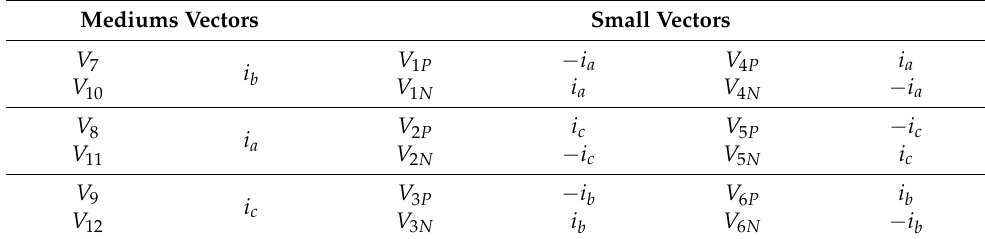
Table 2. The effect of medium and small vectors on the NP.